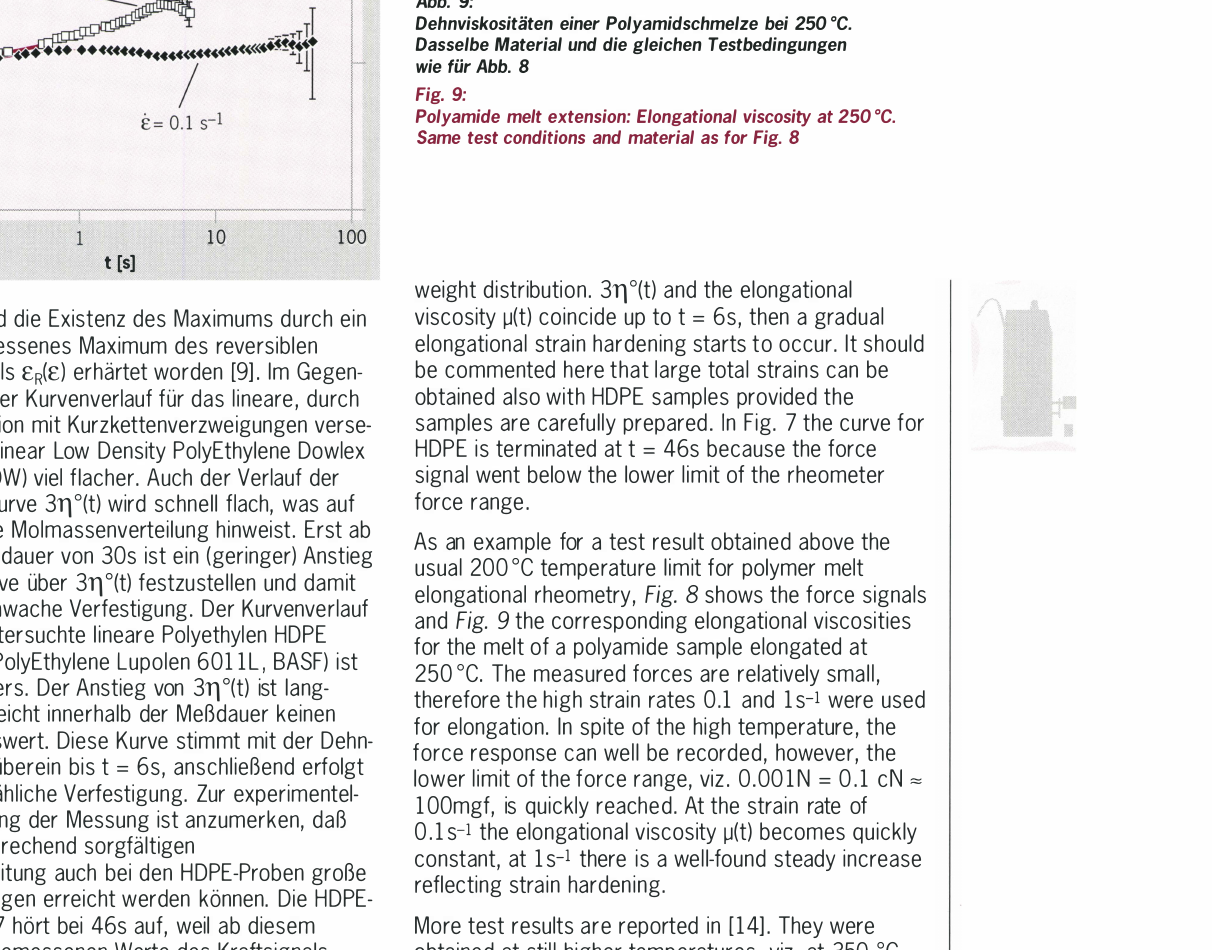
Abb. 9: Dehnviskositiiten einer Polyamidschmelze bei 250 •c. Dasselbe Material und die gleichen Testbedingungen wie fiir Abb. 8 Fig. 9: Polyamide melt extension: Elongational viscosity at 250 •c. Same test conditions and material as for Fig.